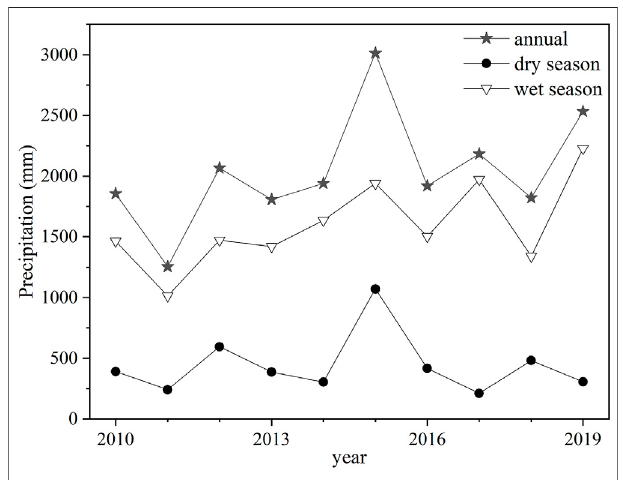
FIGURE 5 | Annual and seasonal precipitation of the Lijiang River Basin from 2010 to 2019.